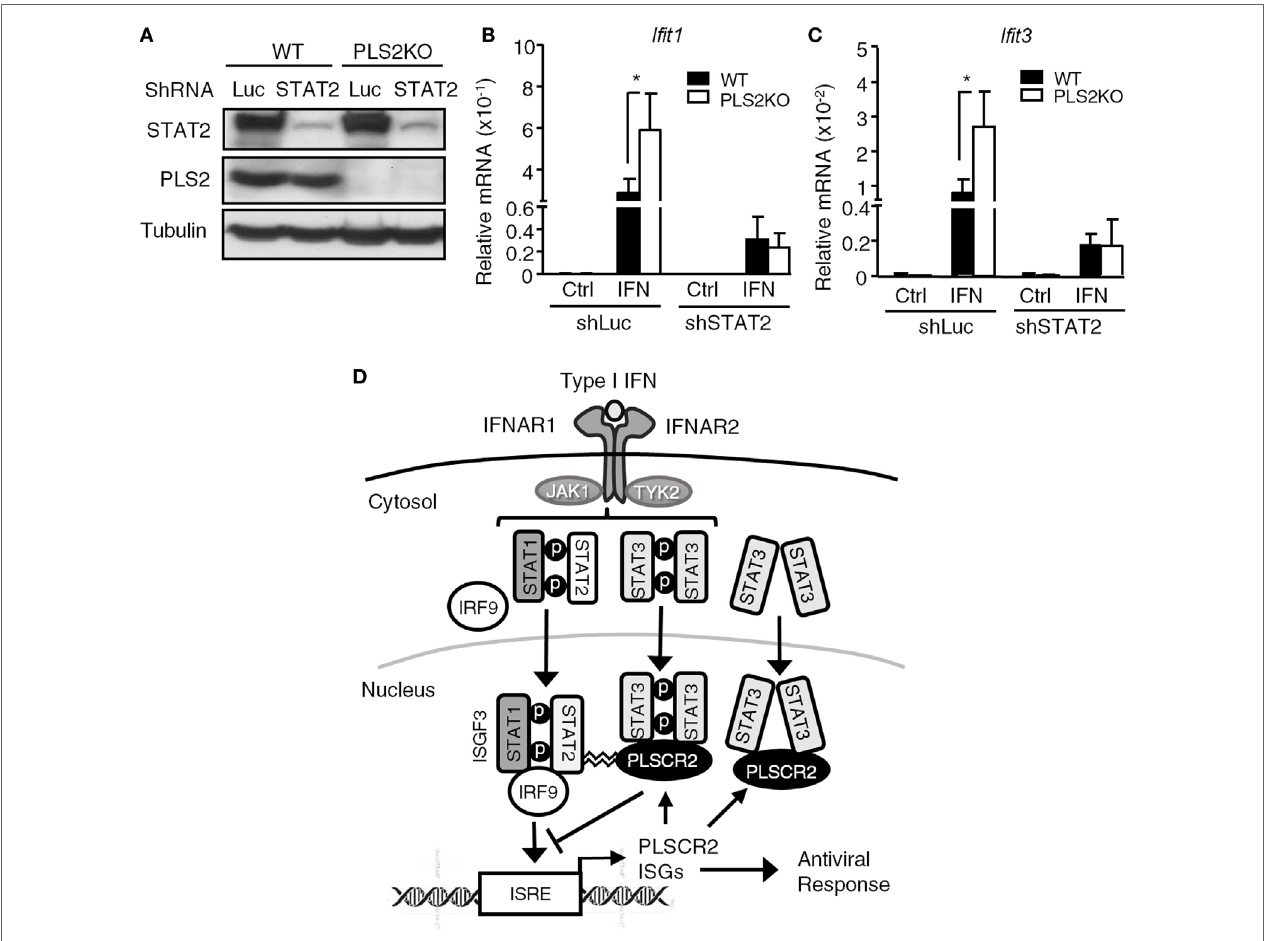
FigUre 7 | The suppressive effect of phospholipid scramblase 2 (PLSCR2) is also STAT2-dependent. (a) WT and PLS2KO ML-1 cells were stably transduced with shLuc or shSTAT2. Total cell lysates were subjected to immunoblotting with antibodies against STAT2, PLSCR2, or tubulin. (B,c) WT or PLS2KO ML-1 cells stably transduced with shLuc or shSTAT2 were stimulated with or without IFN- α 4 for 6 h. Total RNA was subjected to RT-QPCR using primers to Ifit1 (B) , Ifit3 (c) , and Rpl7. Relative mRNA was normalized to Rpl7 ( N = 3) . Data are shown as mean ± SD. * p < 0.05. (D) A model of fine tuning of type I interferon (IFN-I) response by the STAT3–PLSCR2 axis. The binding of IFN-I to IFN receptor activates STAT1, STAT2, and STAT3. Activated STAT1 and STAT2 form ISGF3 complex with IRF9, translocate into the nucleus, bind the promoters, and transactivate downstream IFN-stimulated genes (ISGs) resulting in an antiviral response. One of the ISGs is PLSCR2, which interacts with the N-terminal domain (NTD) of phosphorylated or unphosphorylated STAT3 through its palmitoylation motif. The STAT3–PLSCR2 complex impedes the recruitment of ISGF3 to the promoters, probably in a STAT2-dependent manner, thus suppressing IFN-induced ISGs and the antiviral